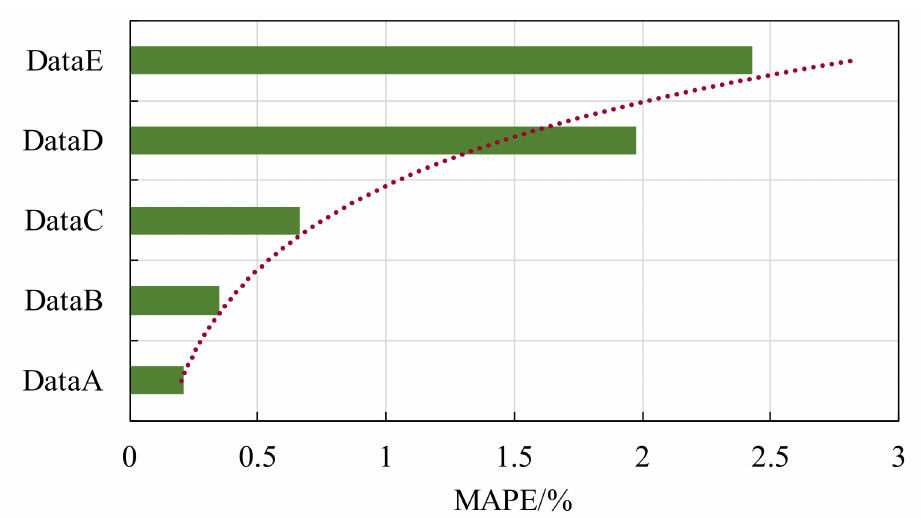
Figure 17. Comparison for MAPE with different input data